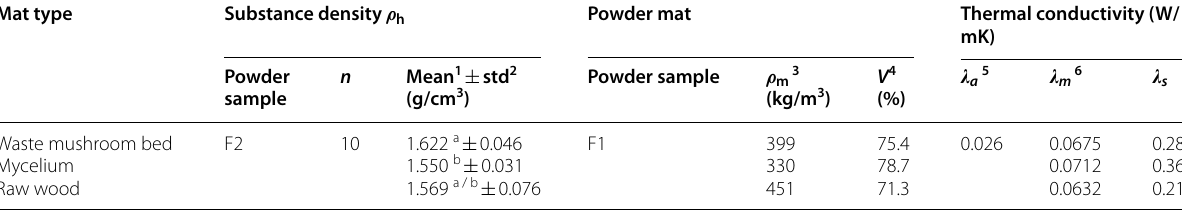
1 Means with different letters are significantly different at P 2 std: standard deviation 3 Air-dry density at which the voids in the mat can be treated as static air ( n 4 Values calculated using Eq. (5) 5 Value corresponding to a specimen temperature of approximately 25 ℃ 6 Values on the regression line in Fig.